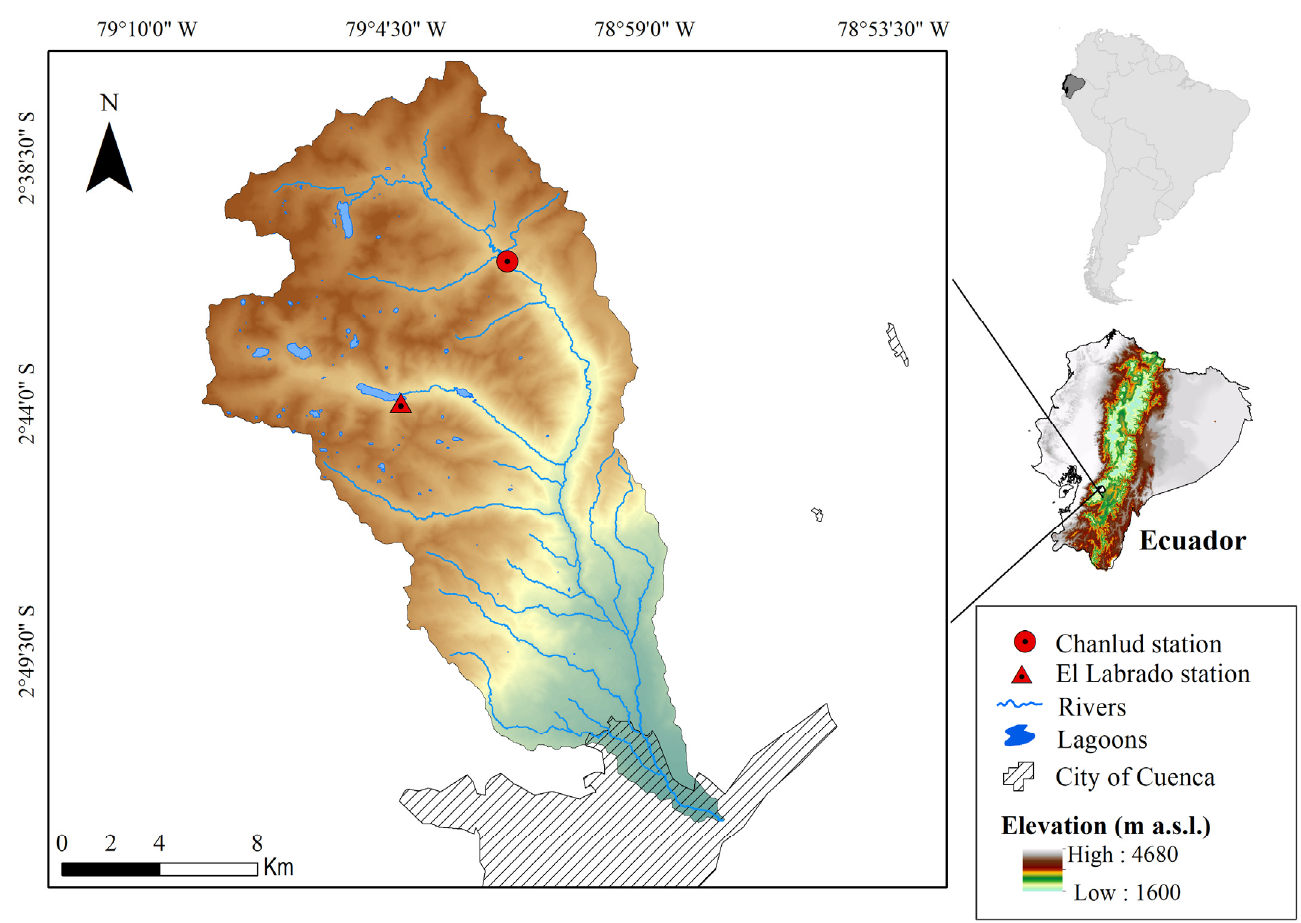
Figure 1. Location of the El Labrado and Chanlúd stations in the Machángara basin in the context of Ecuador and South America.